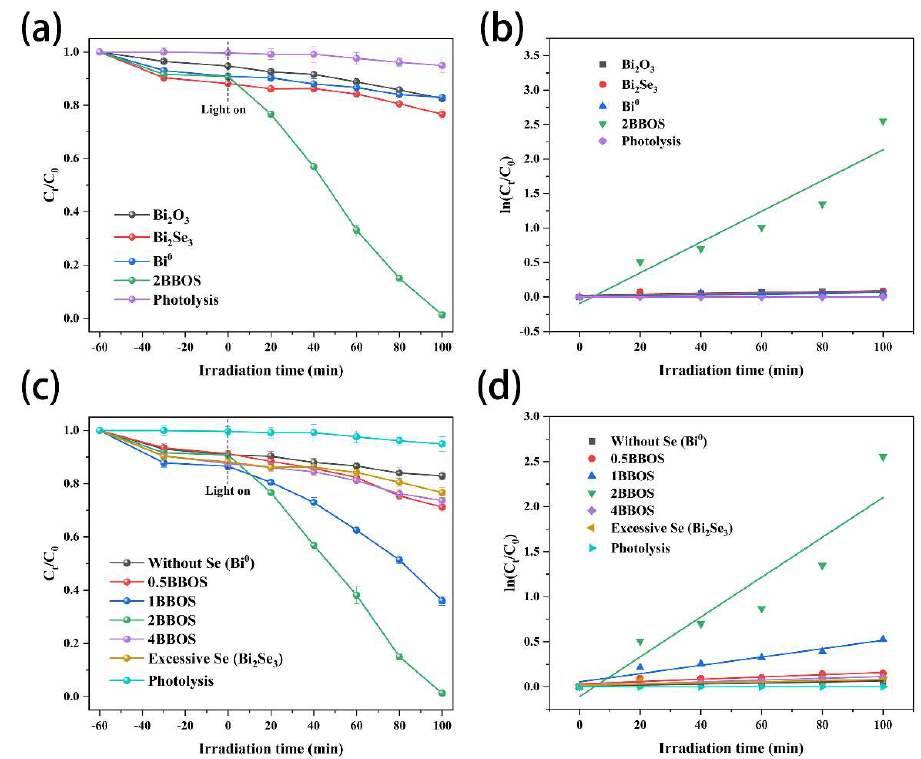
Figure 7. ( a , c ) The photocatalytic performance, ( b , d ) The pseudo-first-order kinetics for ATZ photocatalytic removal performance tests.